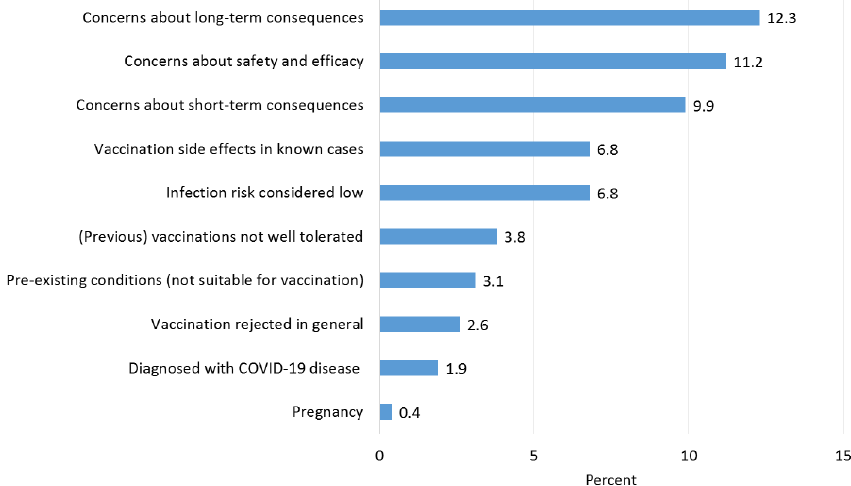
Figure 2. Reasons for hesitating or refusing COVID-19 vaccination (strongly agree/agree; percentage relative to the total sample).